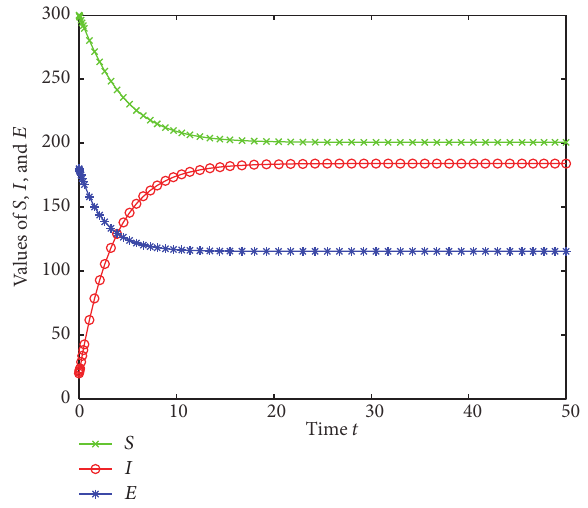
Figure 2: Time plots of 𝑆(𝑡) , 𝐼(𝑡) , and 𝐸(𝑡) for system (1) given in Example 4.